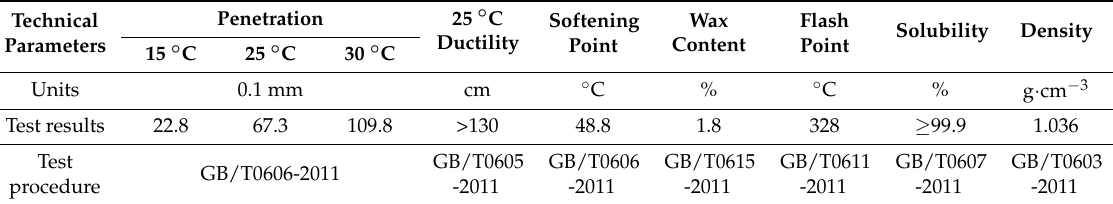
Table 1. Technical parameters of